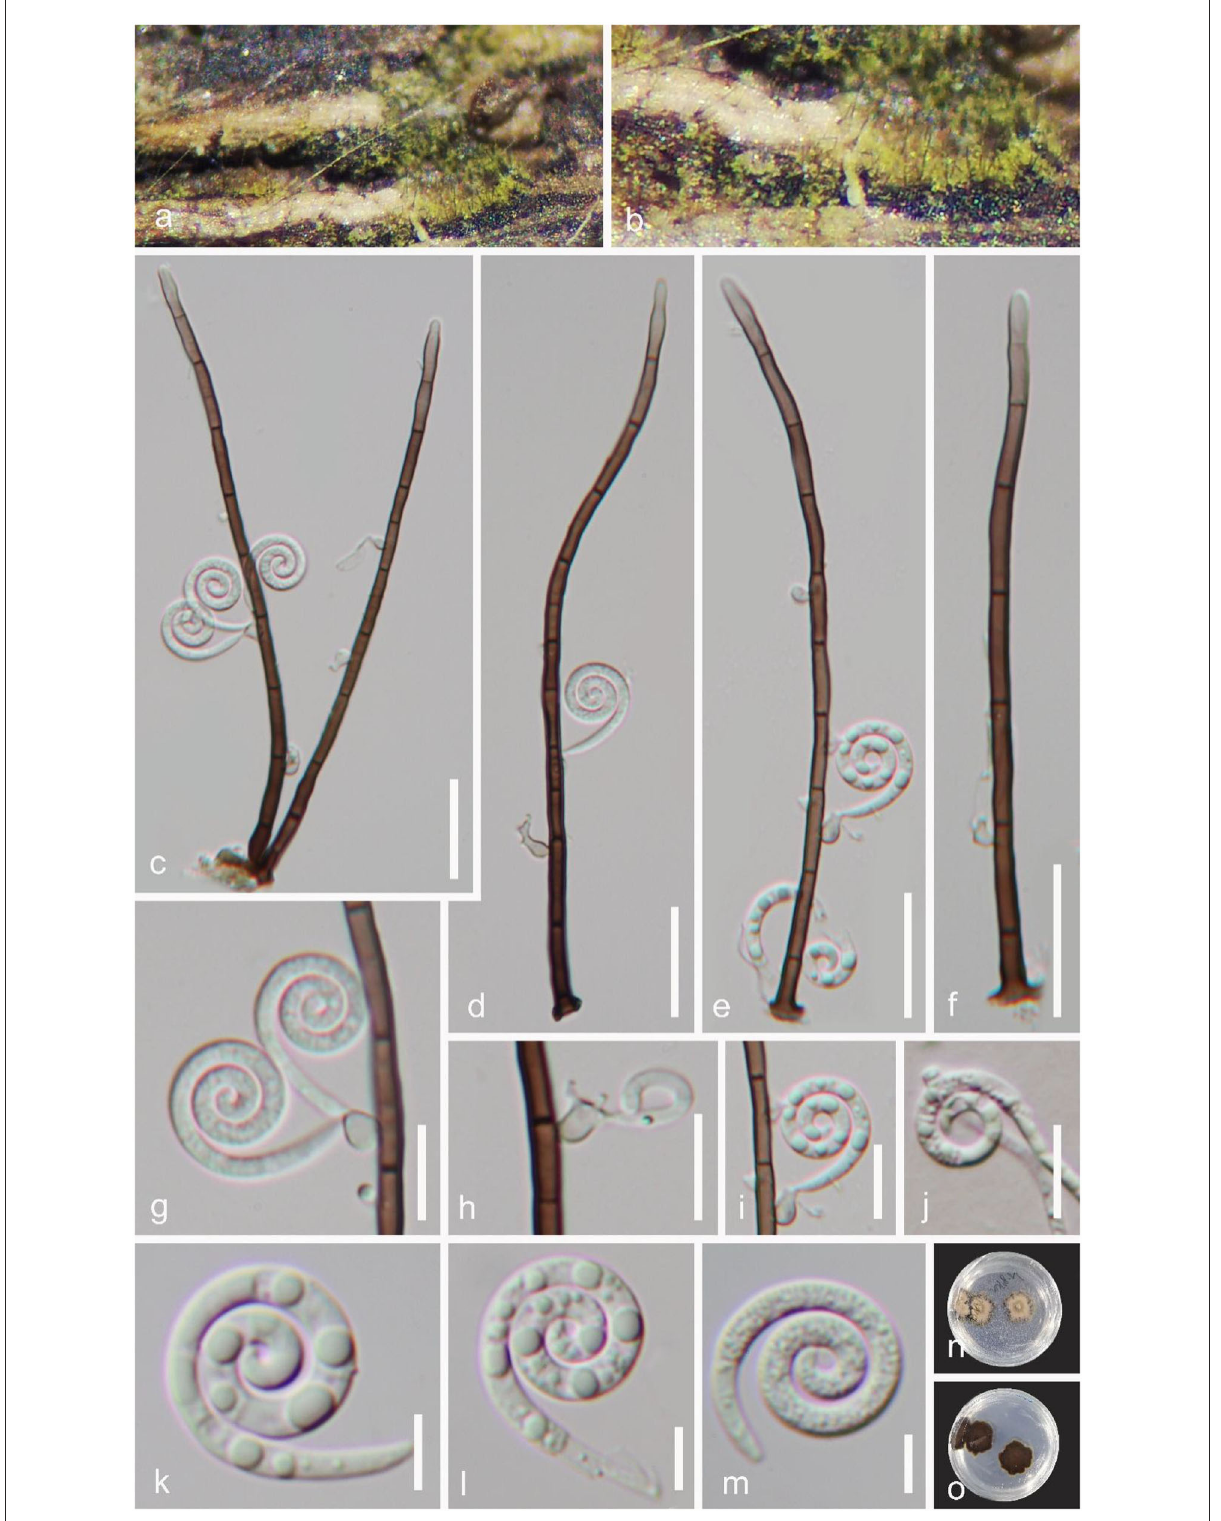
FIGURE6 Helicosporium hainanense (GZAAS 22-2006, holotype). (a,b) Colony on decaying wood. (c–f) Conidiophores and conidia. (g–i) Conidiogenous cells with attached conidia. (j) Germinating conidium. (k–m) Conidia. (n,o) Colonies on PDA observed from above and below. Scale bars: (c–f) = 20 µ m, (g–j) = 10 µ m, (k–m) = 5 µ